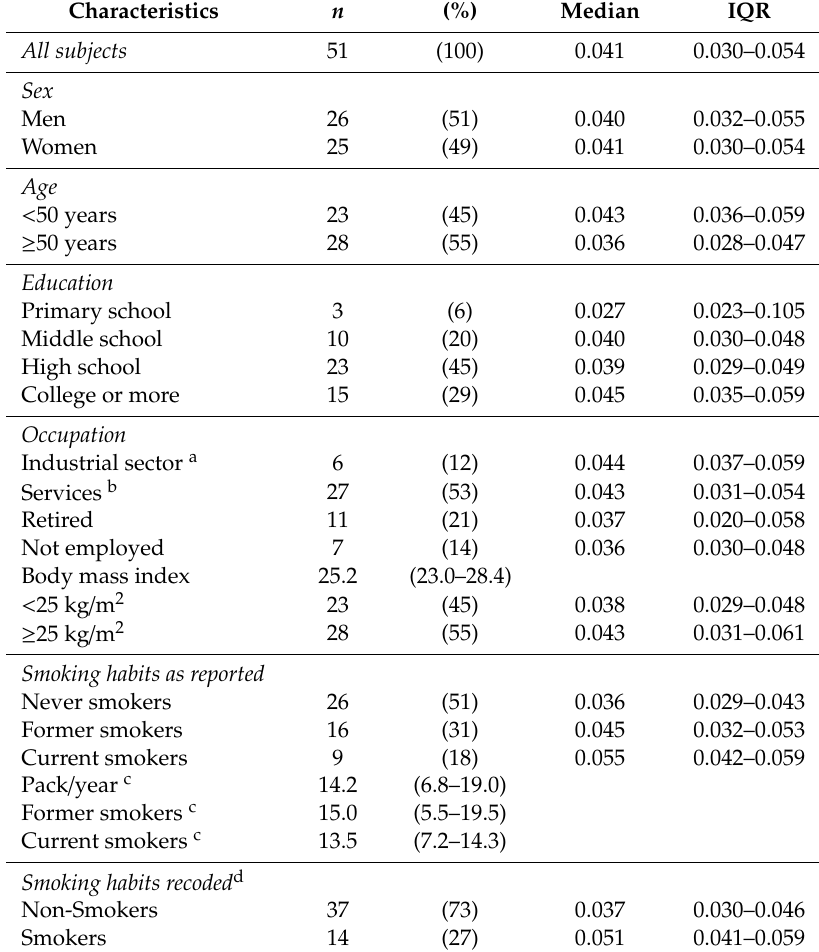
Table 1. Characteristics of study population and cadmium serum median (interquartile range—IQR) levels ( µ g /